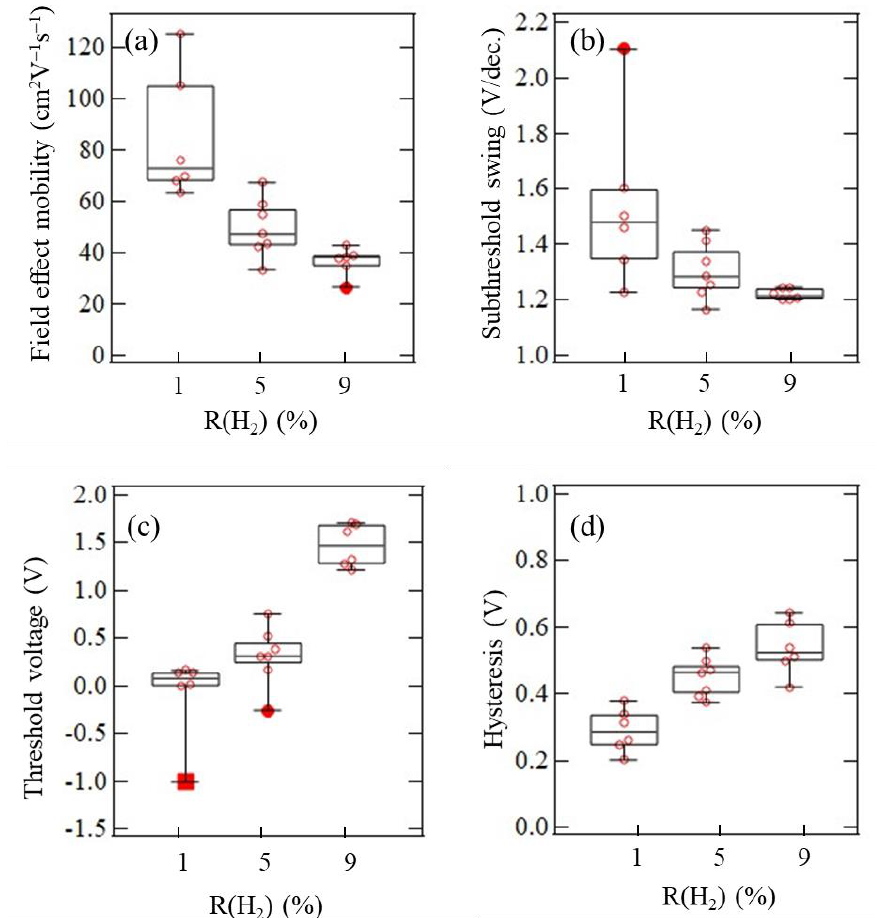
Table 2. Summary of TFT parameters extracted from seven TFTs on same substrate. Figure 9 and Table 2 show the variations of the TFT properties evaluated for seven TFTs on the same substrate. From the poly-InO x :H TFTs with R(H 2 ) of 1% and N e close to the critical carrier density of the MIT point, the maximum and average µ FE values of 125.7 and 84.7 cm 2 V − 1 s − 1 were obtained, respectively. Since a hump was often observed in the subthreshold region of high- µ FE TFTs, the variation of a subthreshold swing ( S.S. ) also increased for the TFTs with R(H 2 ) of 1%. When R(H 2 ) increased, although the average